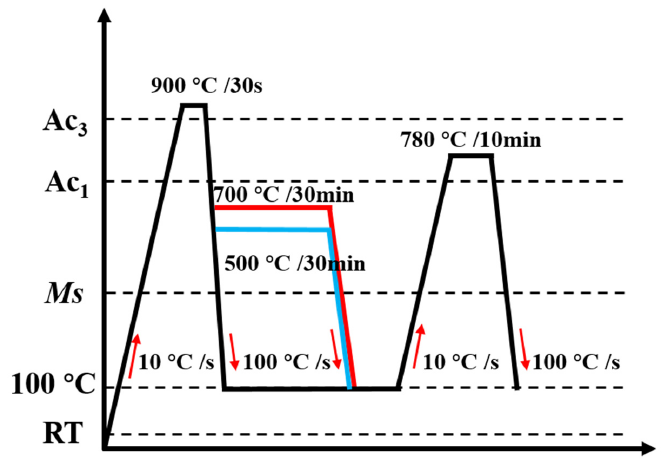
Figure 1. Schematic illustration of thermal processing routes for the present steel. The heating and cooling rates were 10 ◦ C / s and 100 ◦ C / s,